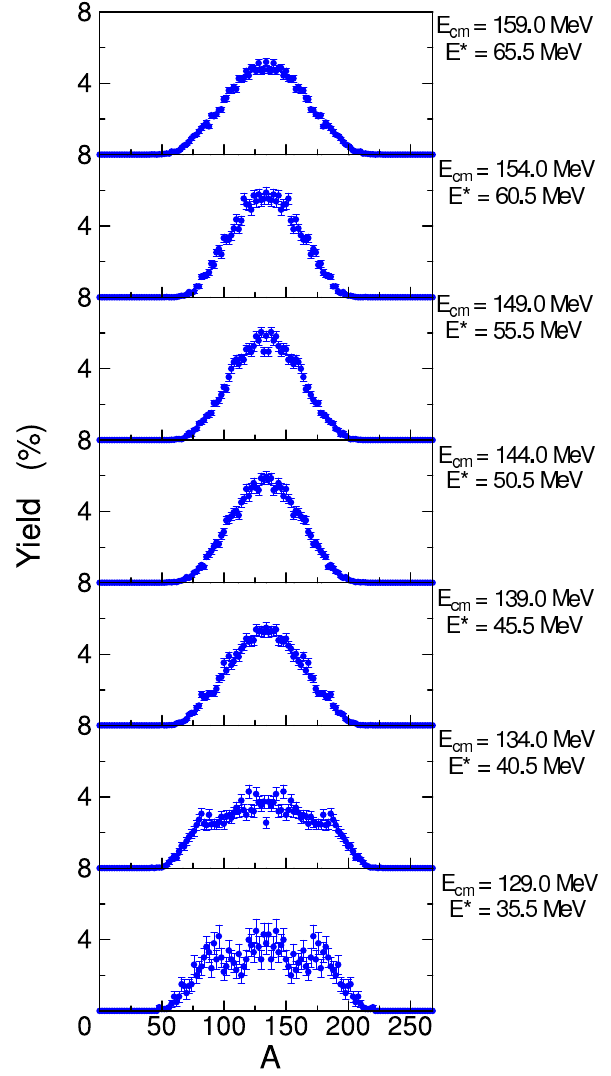
Fig. 2. Mass distributions for the full-momentum transfer fissions of the reaction 30 Si + 238 U. The spectra are obtained by normal- izing the total yields to be 200%. Reaction energies E c . m . and excitation energies E ∗ of the compound nucleus are